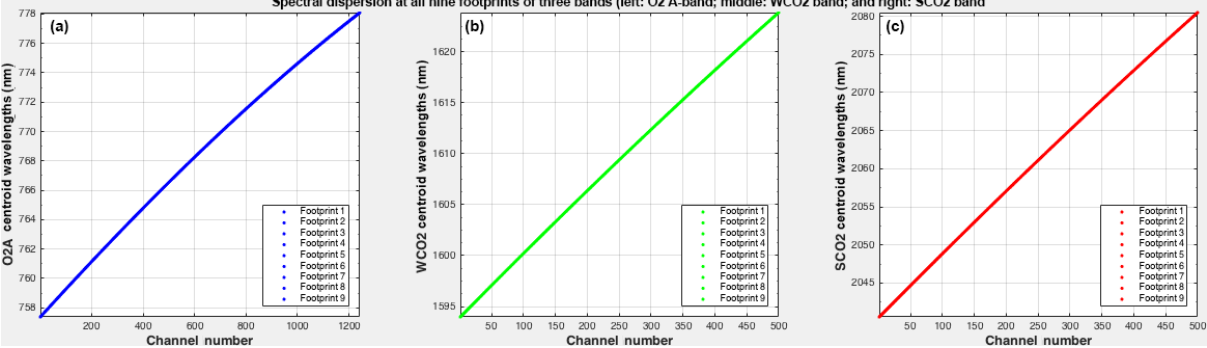
Figure 5. The spectral dispersion at all nine footprints of the three bands: the O 2 A-band ( a ), the WCO 2 band ( b ), and the SCO 2 band ( c